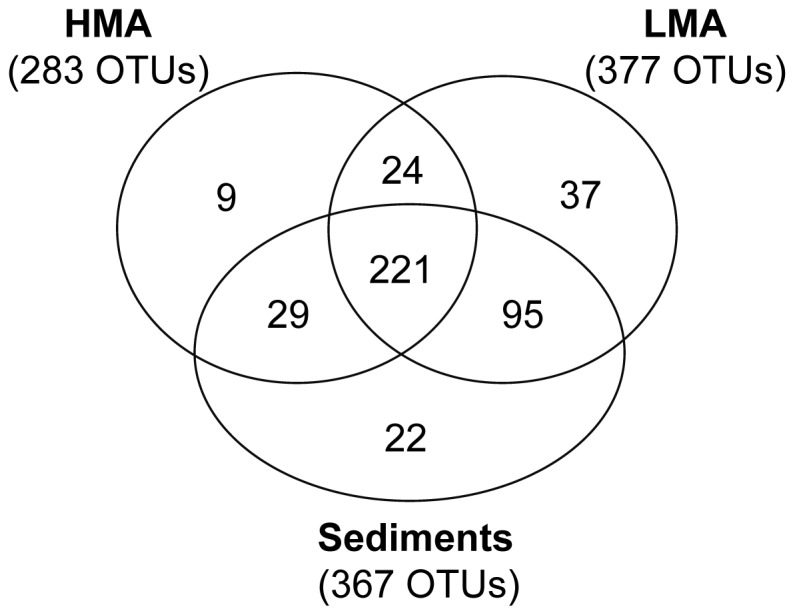
Shared OTUs between HMA sponges, LMA sponges, and sediments.The Venn diagram displays the number of OTUs unique to or shared between the three major sample groupings, with total OTU numbers for each grouping indicated in parentheses.